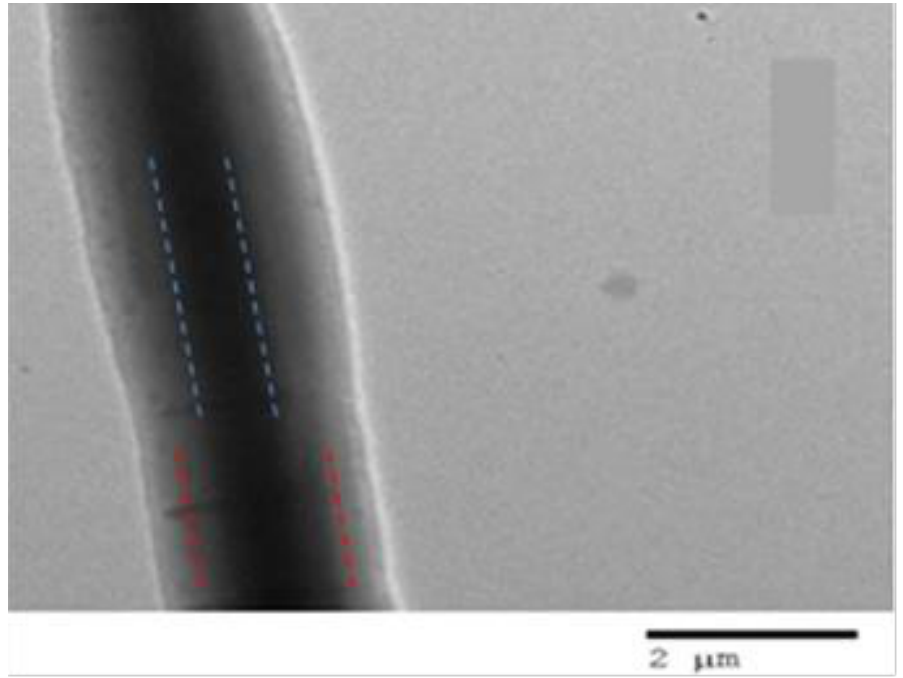
Figure 11. TEM image of Triaxial electrospun fibre with PCL (core, blue doted line), RhB, BSA-FITC- gelatin (intermediate, red dotted line) layer and PLGA (50:50) (sheath) (scale bar 2 μm) . Reproduced with permission from [126], copyright 2020 Scientific Reports.